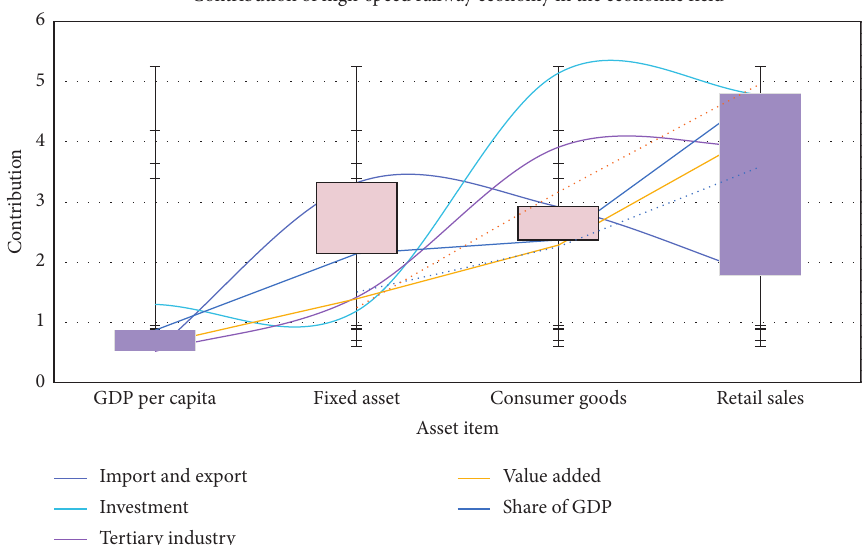
Figure 11: Contribution of high-speed railway economy in the economic field.